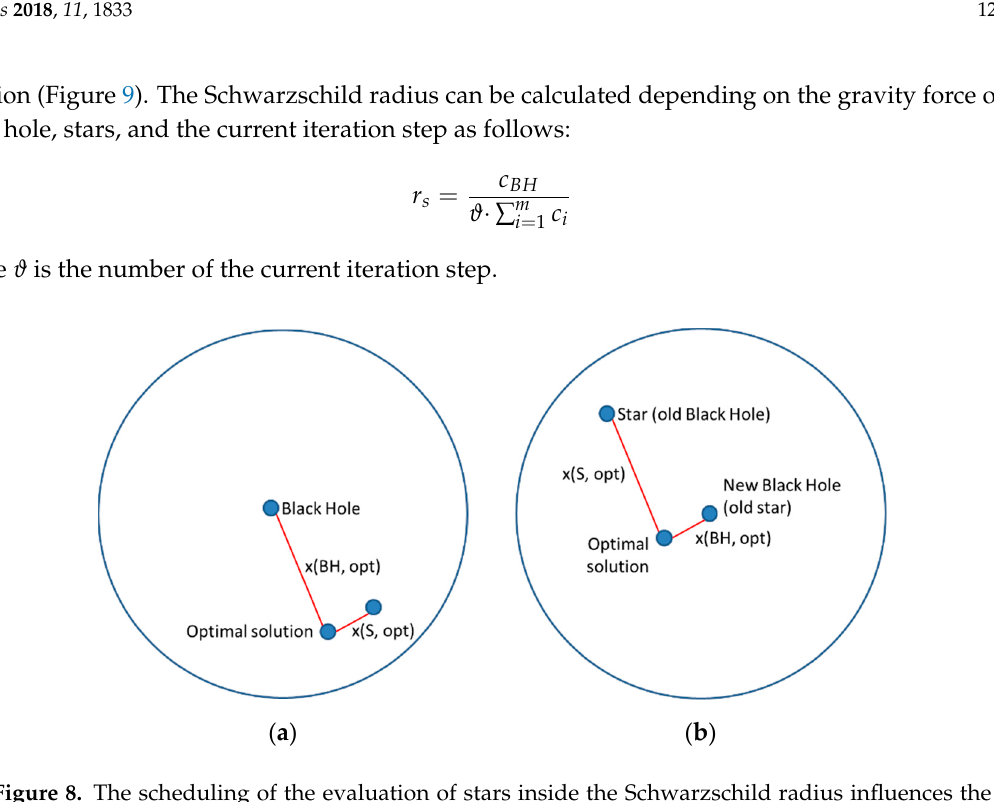
Figure 8. The scheduling of the evaluation of stars inside the Schwarzschild radius influences the convergence speed of the algorithm: ( a ) If the stars inside the event horizon are not evaluated before absorbed, then the distance between optimal solution inside the event horizon and the black hole should be higher than the distance between the optimal solution and the star; ( b ) If the star inside the event horizon is evaluated, then the star with a better value of objective function could become the new black hole, while the old black hole becomes a star.